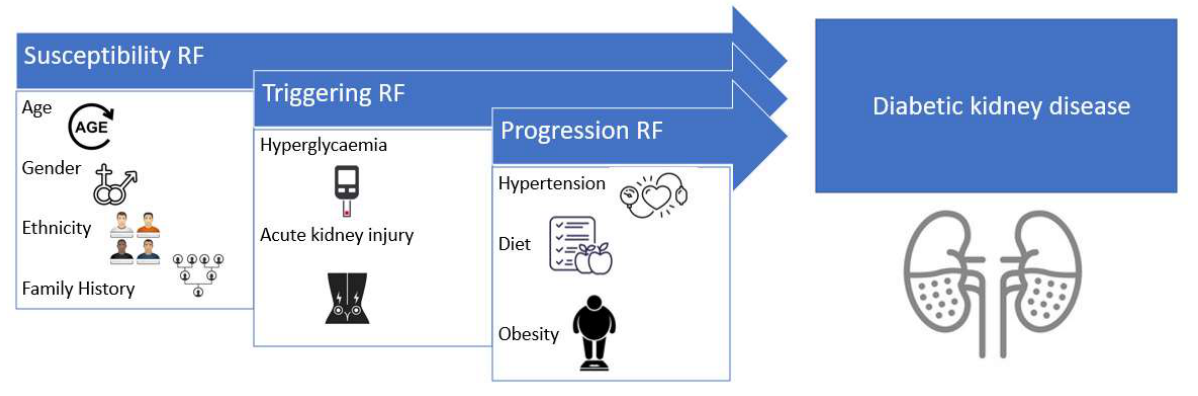
Figure 3. Risk factors for developing diabetic kidney disease.